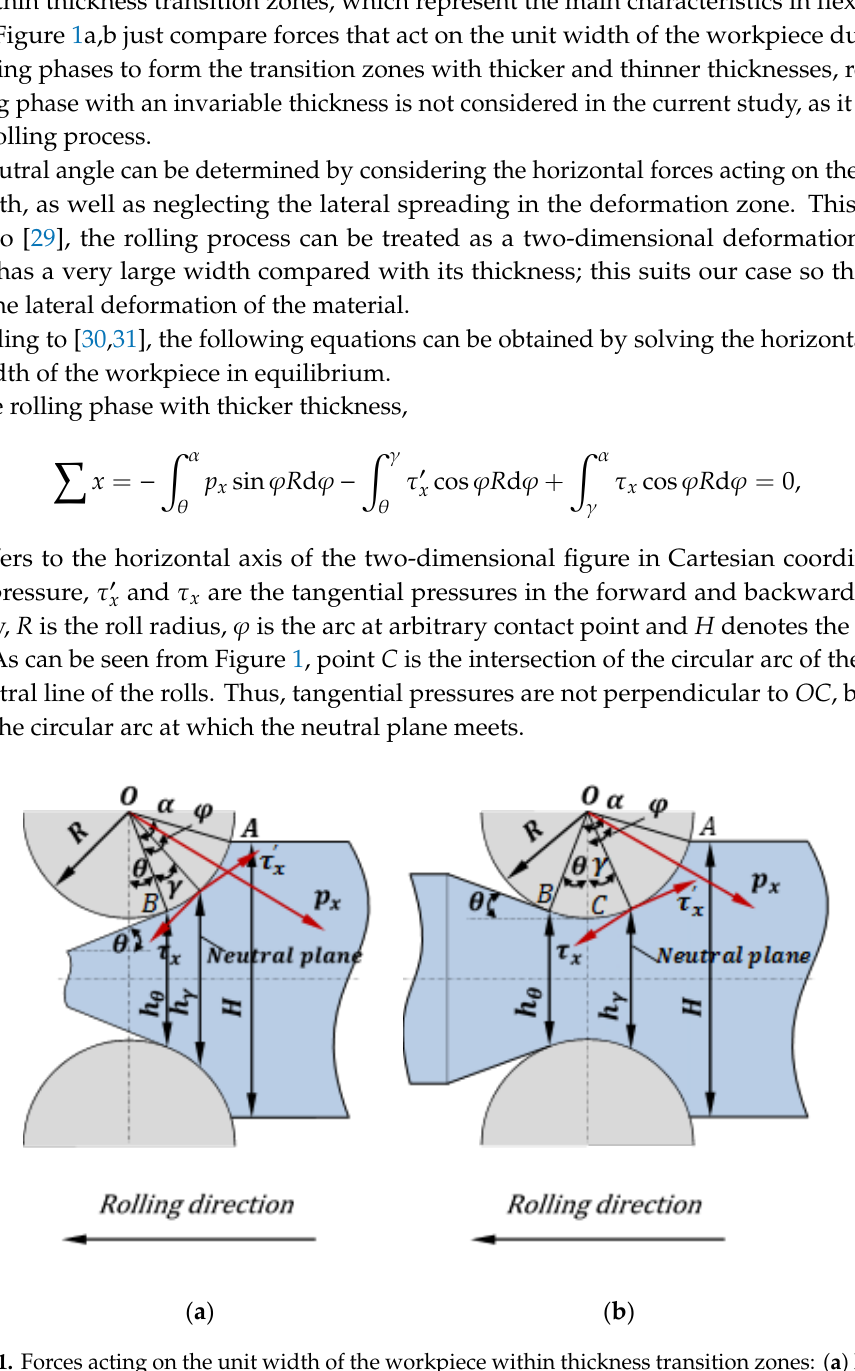
Figure 1. Forces acting on the unit width of the workpiece within thickness transition zones: ( a ) Rolling phase to form transition zone with thicker thickness; and ( b ) rolling phase to form transition zone with a thinner thickness (for the deformation area below arc AC ) [32].